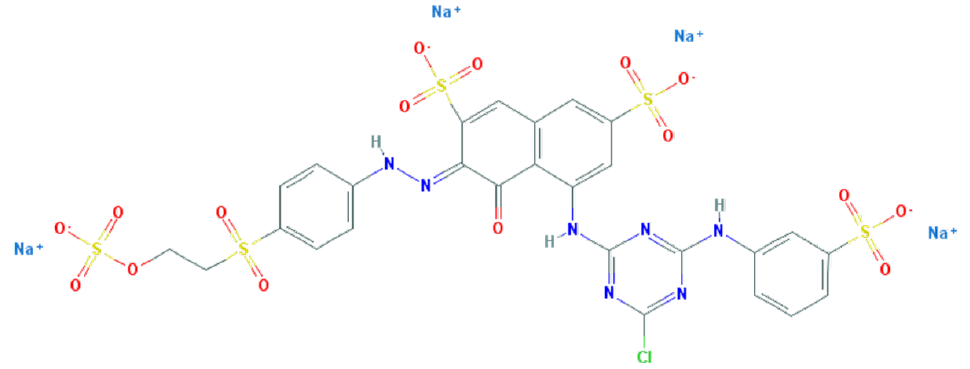
Fig 1. The structure of the chemical composition of Reactive Red 198.